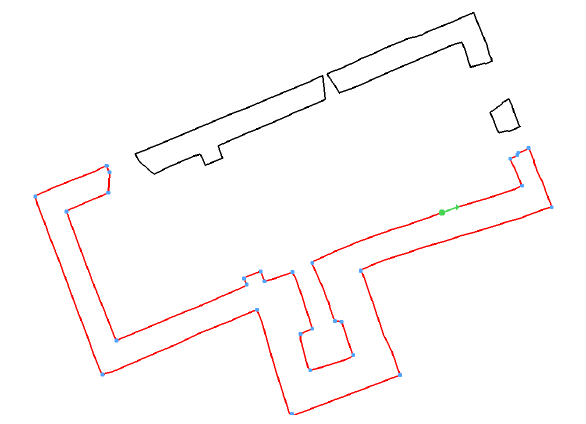
Figure 2: Wall plan of the small Church of Figure (1), with pro- cessed element in red, detected corners represented with cyan